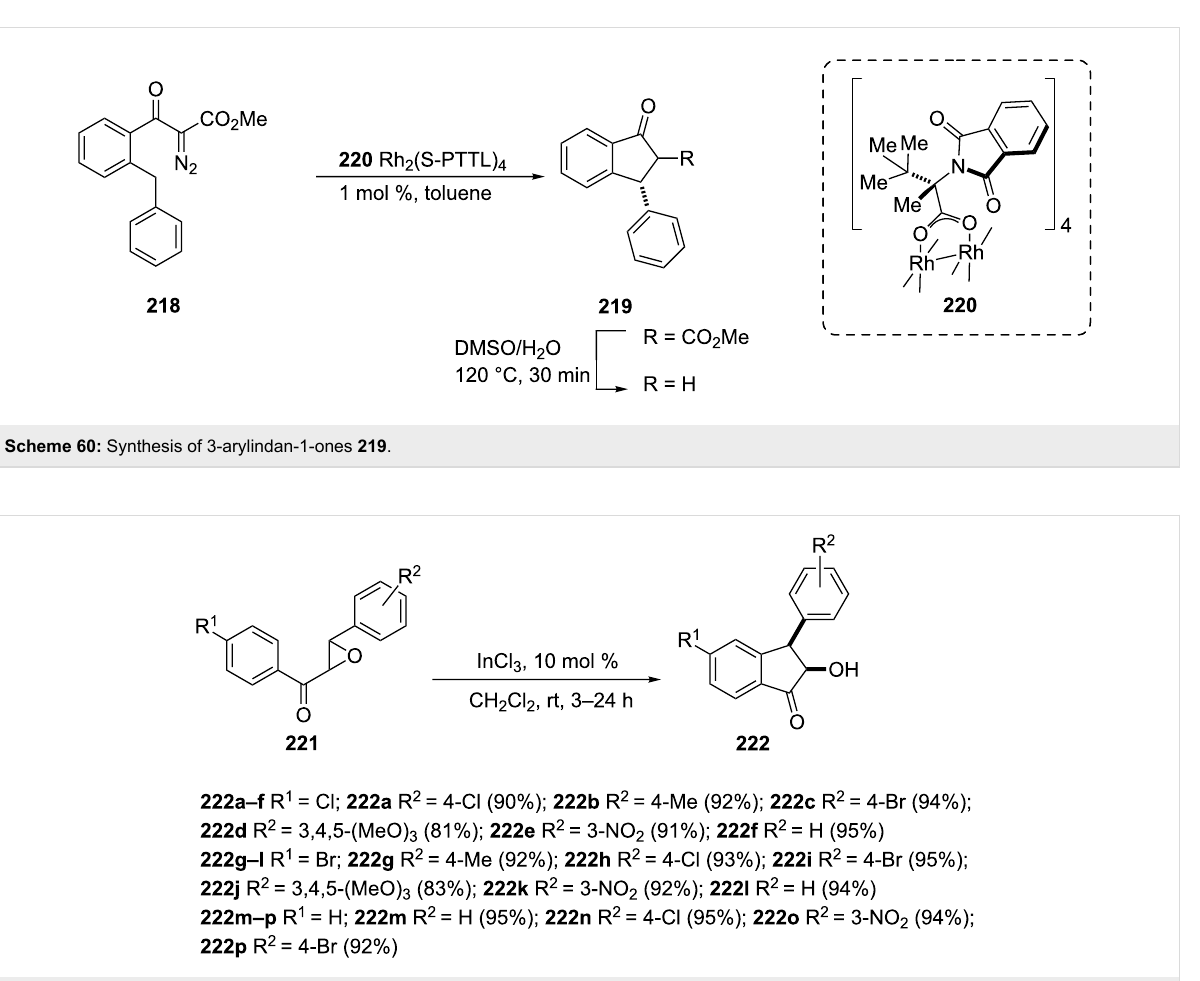
Scheme 61: Synthesis of 2-hydroxy-1-indanones 222